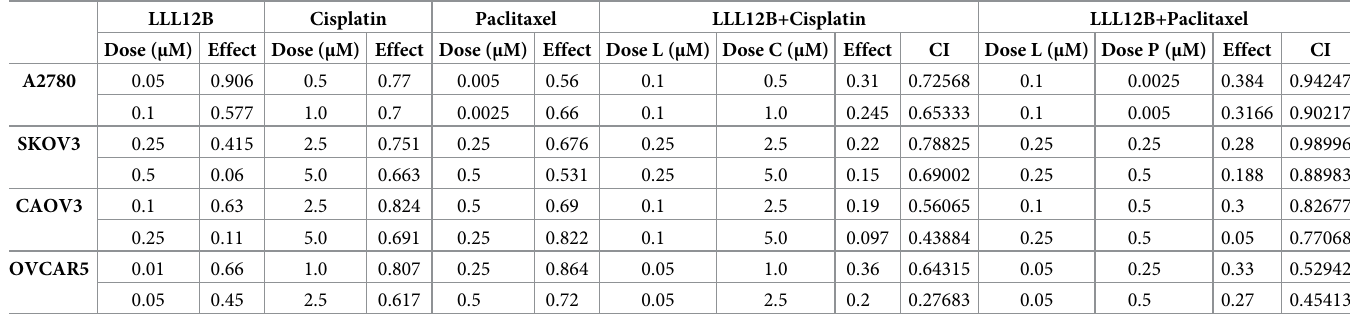
Table 1. The calculation of the combination index (CI).